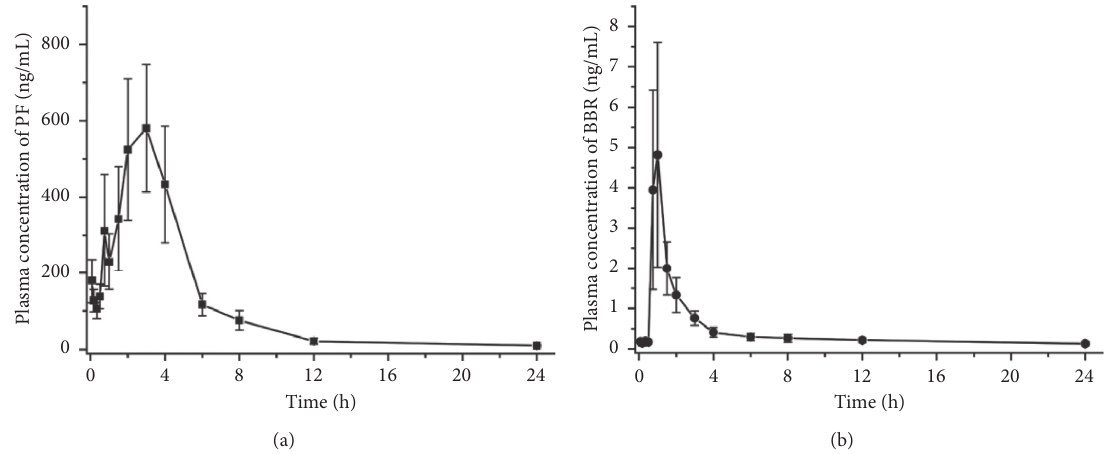
Figure 6: Mean plasma concentration-time curve of PF and BBR after a single dose of BSPs in rats. Table 3: The main pharmacokinetic parameters of PF and BBR after dosing with BSPs in rats (mean ± SD, n � 5).